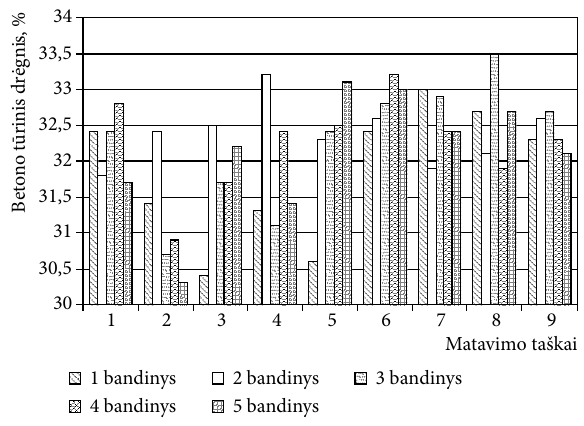
5 pav. D1 serijos sudėties betono vidutinio tūrinio drėgnio matavimų sklaida penkiuose kubeliuose bandymo pradžioje Fig. 5. The spread of the measurements of the average moisture content of D1 series concrete in five cubes at an early investigation stage